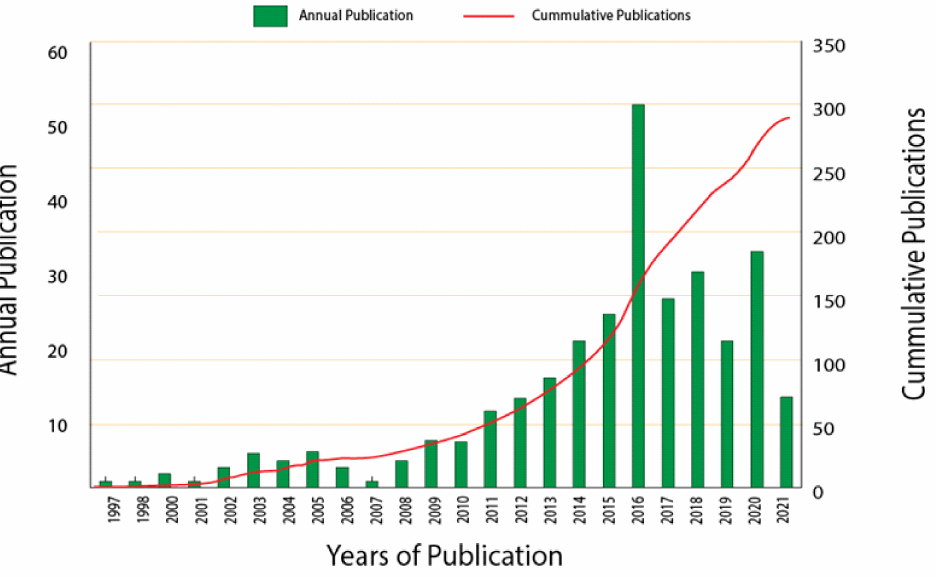
Figure 7. Annual and cumulative publications on antimicrobial packaging for various